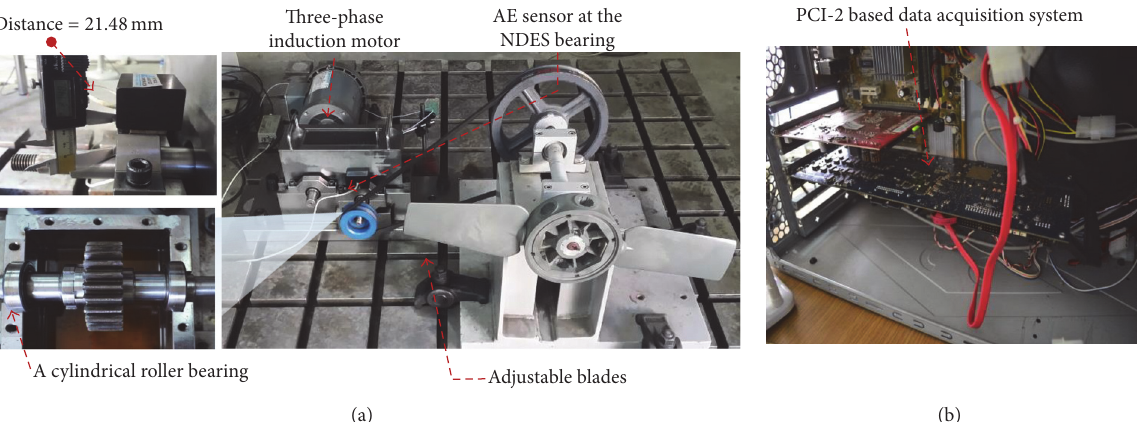
Figure 2: (a) The fault simulator with a three-phase induction motor, a wide-band acoustic sensor, gearbox, and (b) a PCI-2 based system for AE data acquisition.